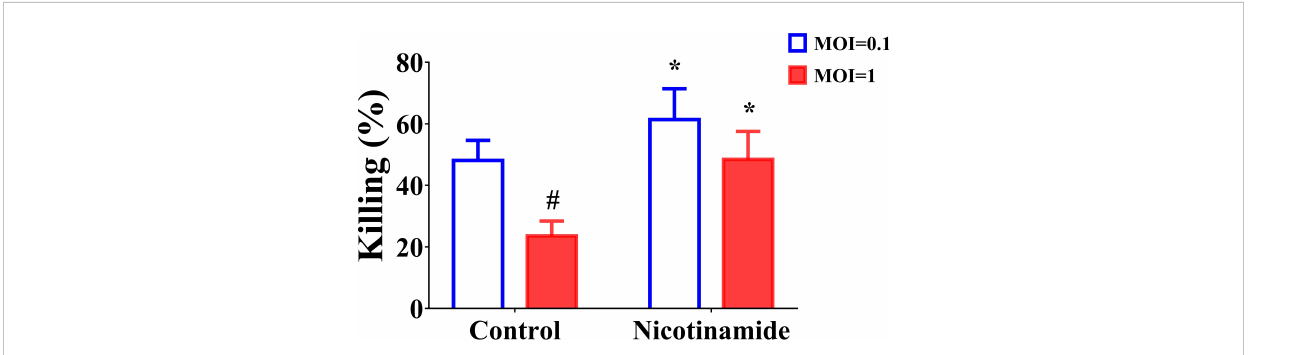
FIGURE 6 Fungal killing assay. THP-1 macrophages were incubated with MOI = 0.1 or MOI = 1 A. fumigatus conidia for 1 h, and a fungal killing assay was performed 4 h after the removal of the unbound conidia. # P < 0.05 vs. MOI = 0.1 control group; * P < 0.05 vs. the respective control